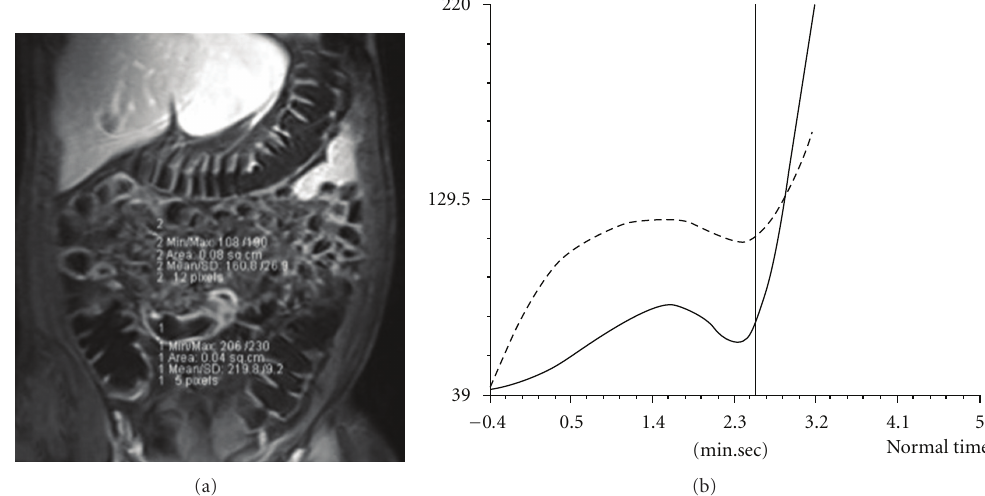
Figure 9: MR-E. (a) Coronal TRUFI T2 showing ileal loop wall thickening. (b) Intensity/time curve not showing inflammatory activity.